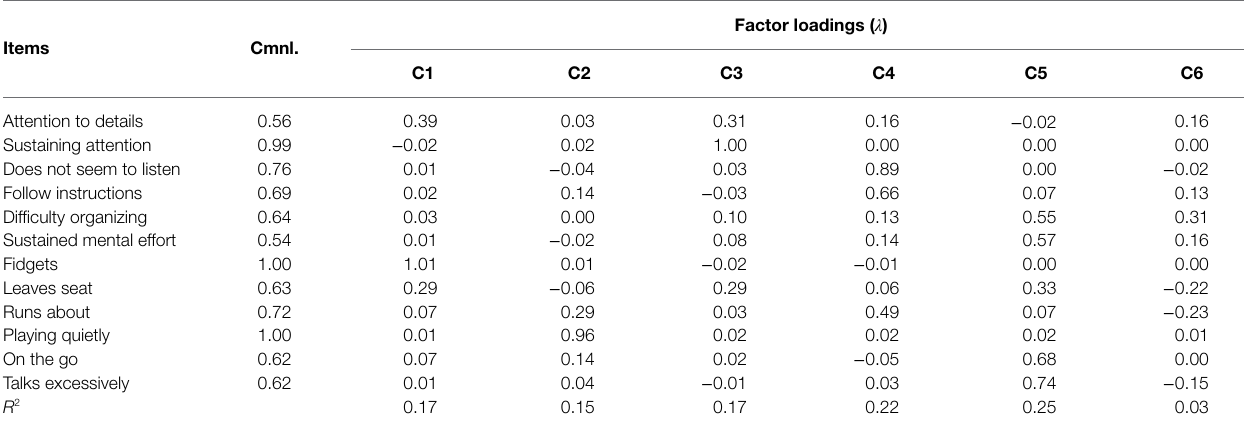
TABLE 4 | EFA-results for the impairment items 25 of the ADHD Rating